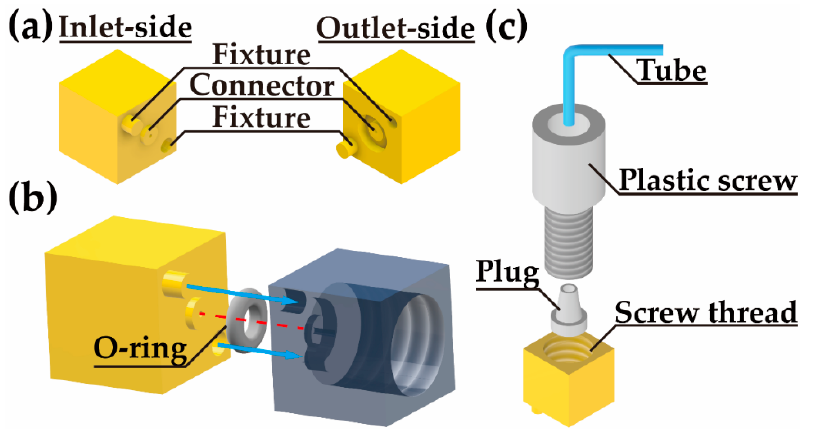
Figure 1. Schematics of the standard droplet generation modules. ( a ) Inlet and outlet sides of the standard modules. ( b ) The connection of the two modules. ( c ) Schematic diagram of the installation of the tube.